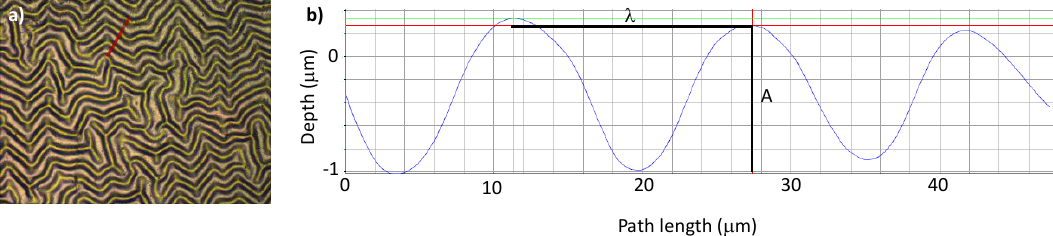
Figure 3. Infinite Focus Microscopy (IFM) of N1 thin film deposited onto PDMS: ( a ) optical image; ( b ) 2D profile over 50 µ m (red line in a)) enabling wrinkle wavelength ( λ ) and amplitude (A) determination. (In b) red line correspond to the measured length, green lines were used to evaluate amplitude, and blue line is the 2D profile of the surface). Table 1. Wavelength, amplitude, and micrometer roughness parameters, determined by IFM, of the PA thin films deposited onto PDMS